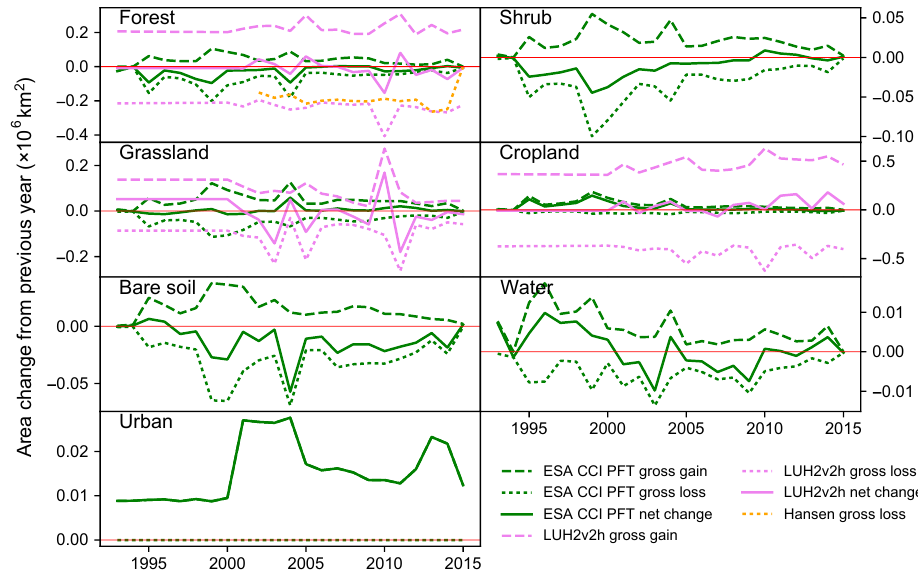
Figure 2. Gross changes in PFTs from 1992 to 2015 after translating gross transitions between original ESA land cover classes. Gross changes from LUH2v2h (Hurtt et al., 2011) and Hansen et al. (2013) are also shown for comparison. The red line indicates the zero